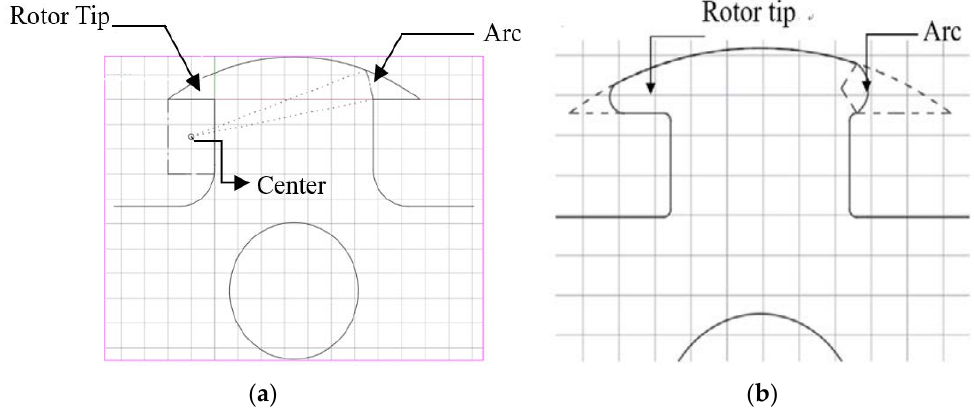
Figure 2. Optimization designs. ( a ) Design 1; ( b ) Design 2.